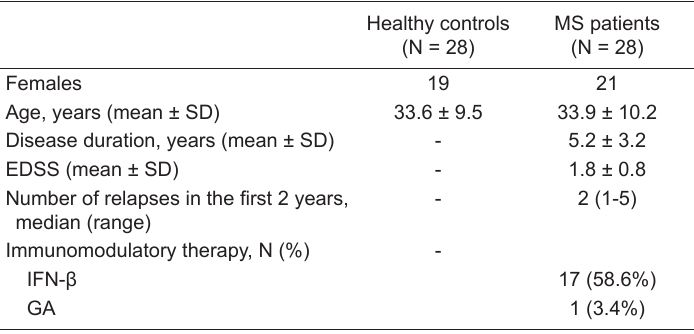
Table 1. Clinical and demographic details of multiple sclerosis (MS) patients and